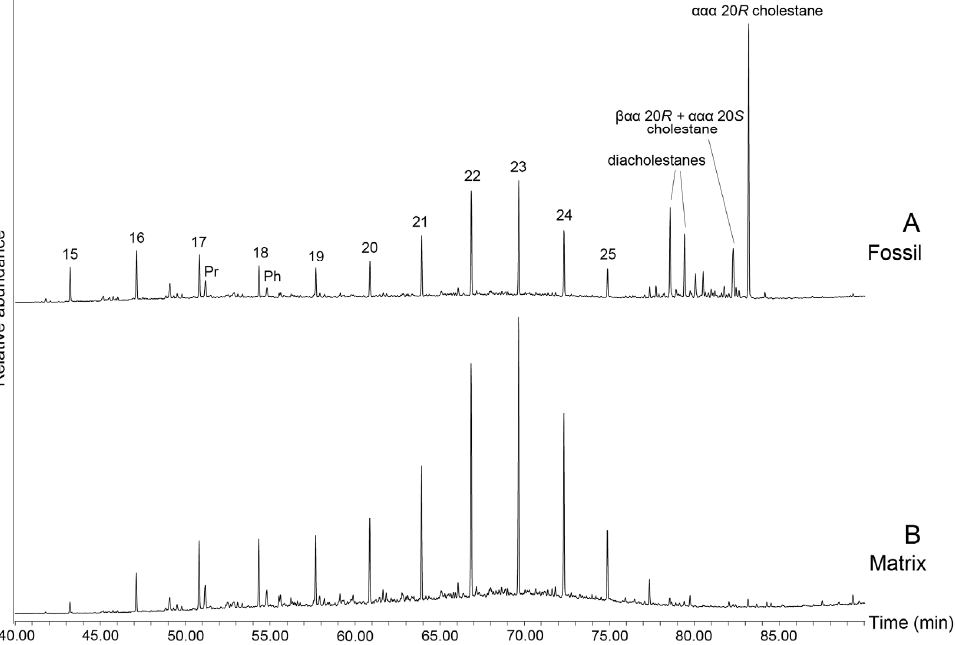
Figure 7. GC-MS total ion chromatogram of PE 52336 showing differences in n -alkanes distribution and cholestanes abundances in the Fossil (A) versus the Matrix (B). Numbers represent the carbon number of the hydrocarbon chain. Pr = pristane, Ph =